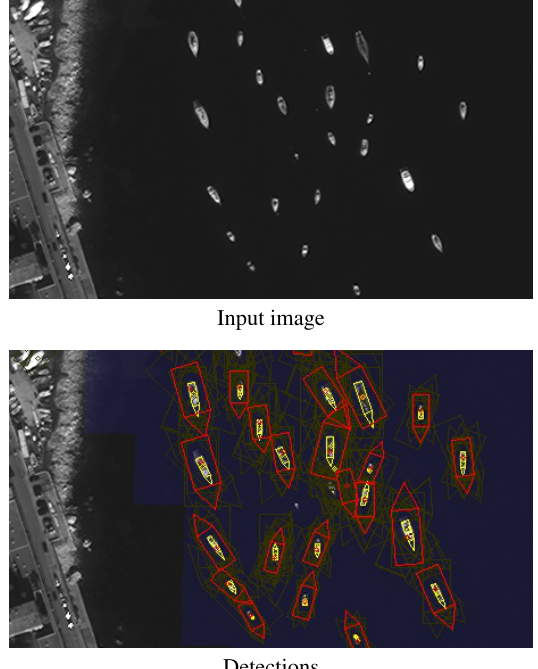
Figure 7: Results for WV2 image at Nizza,